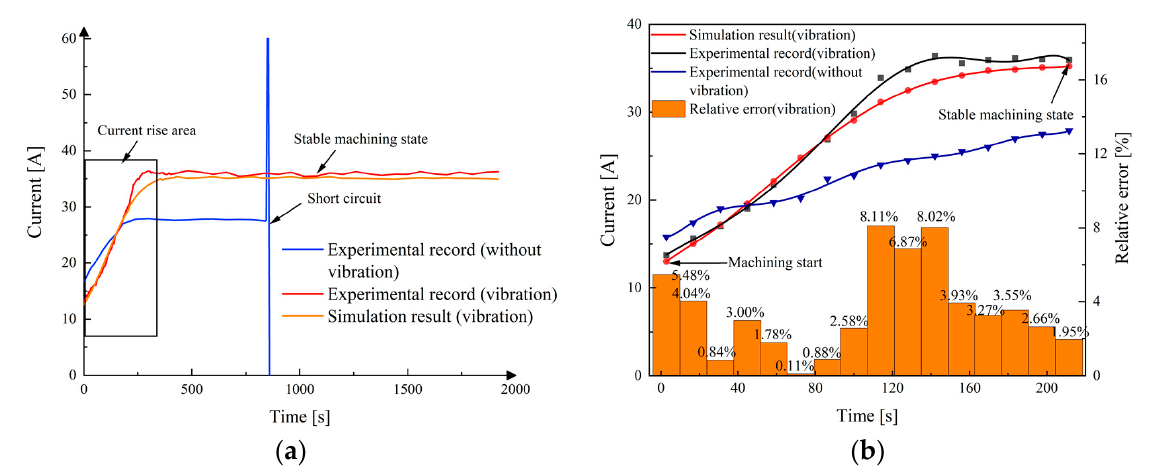
Figure 16. The changes of machining current experiment and simulation over time; ( a ) whole ma- chining time; ( b ) enlarged view of current in rising time.